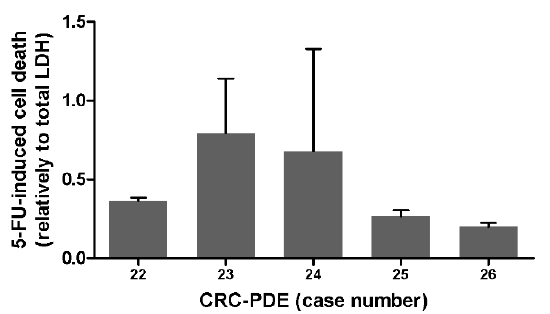
Figure 4. Drug challenge in CRC-PDE cultures. Drug-induced cell death determined by LDH leakage relative to total LDH content, in different CRC-PDE cultures, after 2 weeks of drug exposure. 5-FU 5-fluorouracil, CRC-PDE colorectal cancer patient-derived explant culture. Drug-induced cell death ranged from 20 to about 70% of the total CRC-PDE, depend-